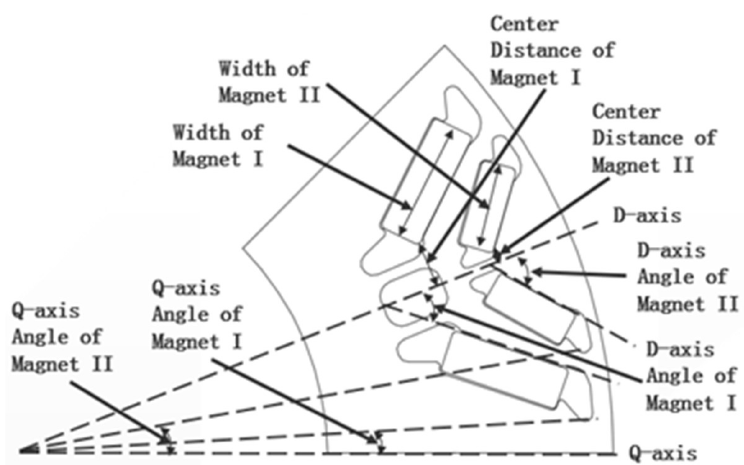
Figure 8. Parametric model of rotor.